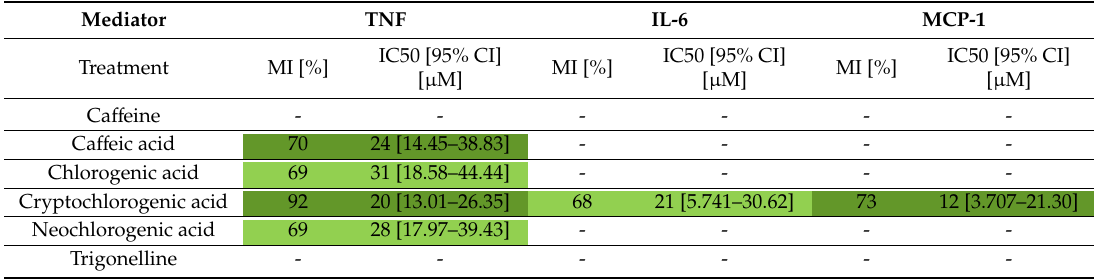
Table 2. Summary of inhibitory e ff ects of ca ff eine, ca ff eic acid, chlorogenic acid isomers, and